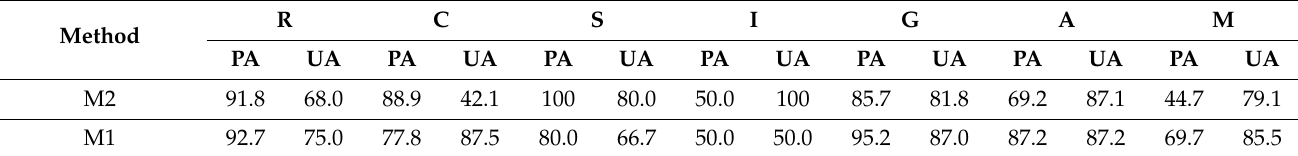
Table 4. Comparison of the accuracy of identifying urban functional areas using different